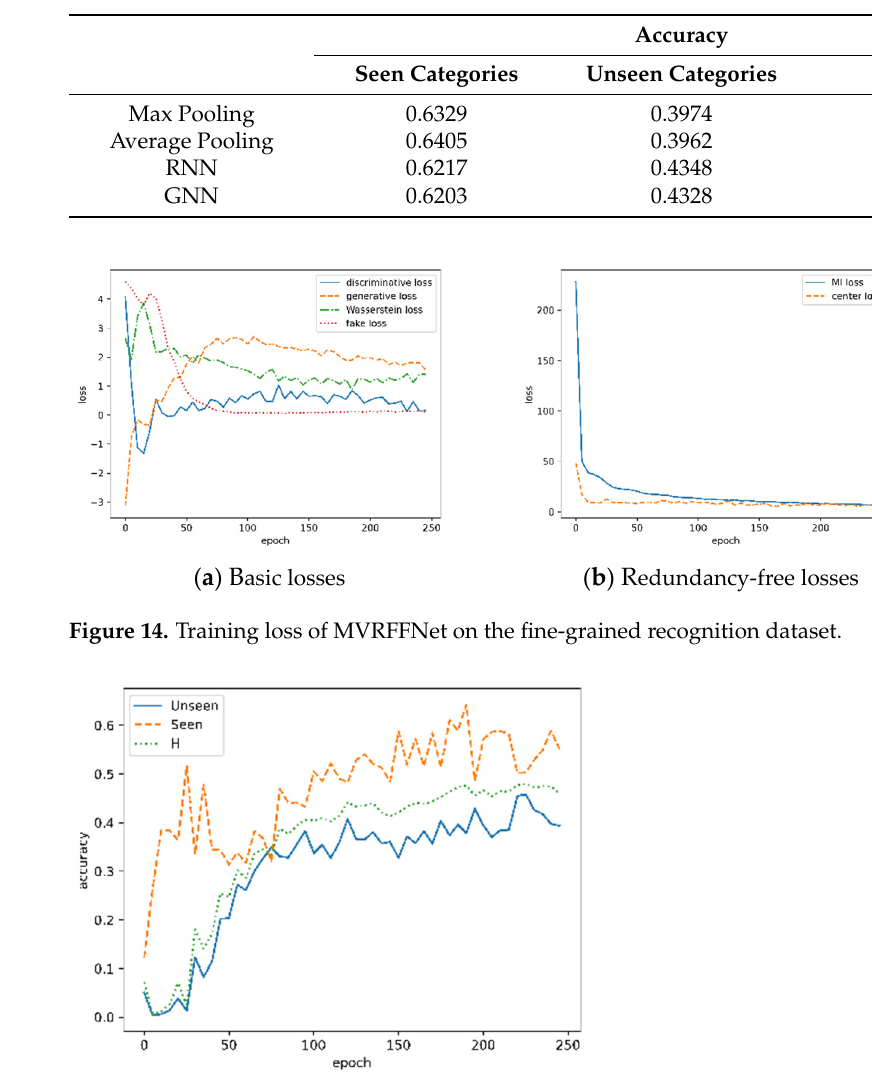
Table 6. Classification accuracy of the MVRFFNet on the fine-grained recognition dataset.